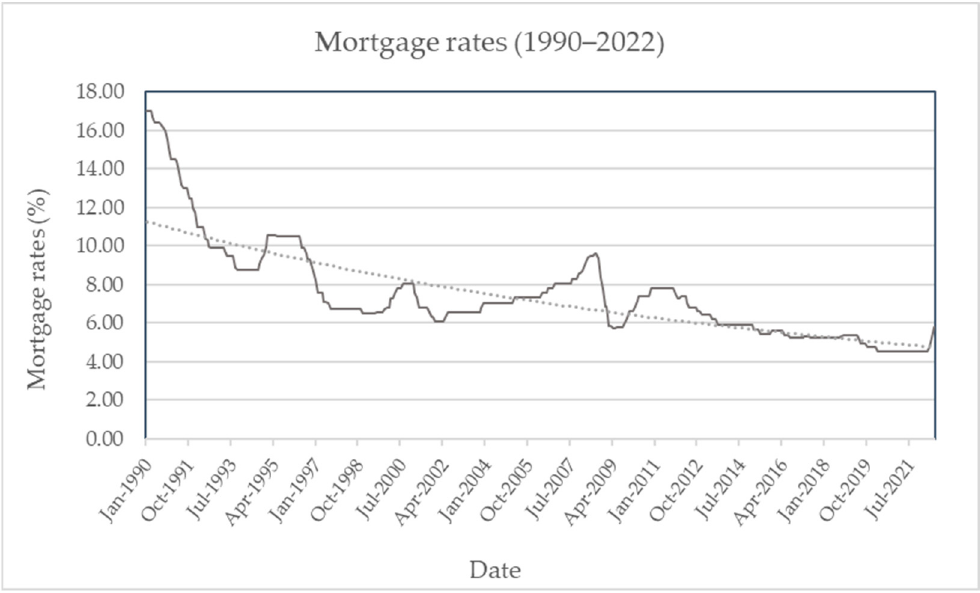
Figure 2. Mortgage rates (1990–2022). (Data Source: Reserve Bank of Australia, accessed on 3 September 2022). Note: Dashed line indicates that mortgage rate is on a downward trend.